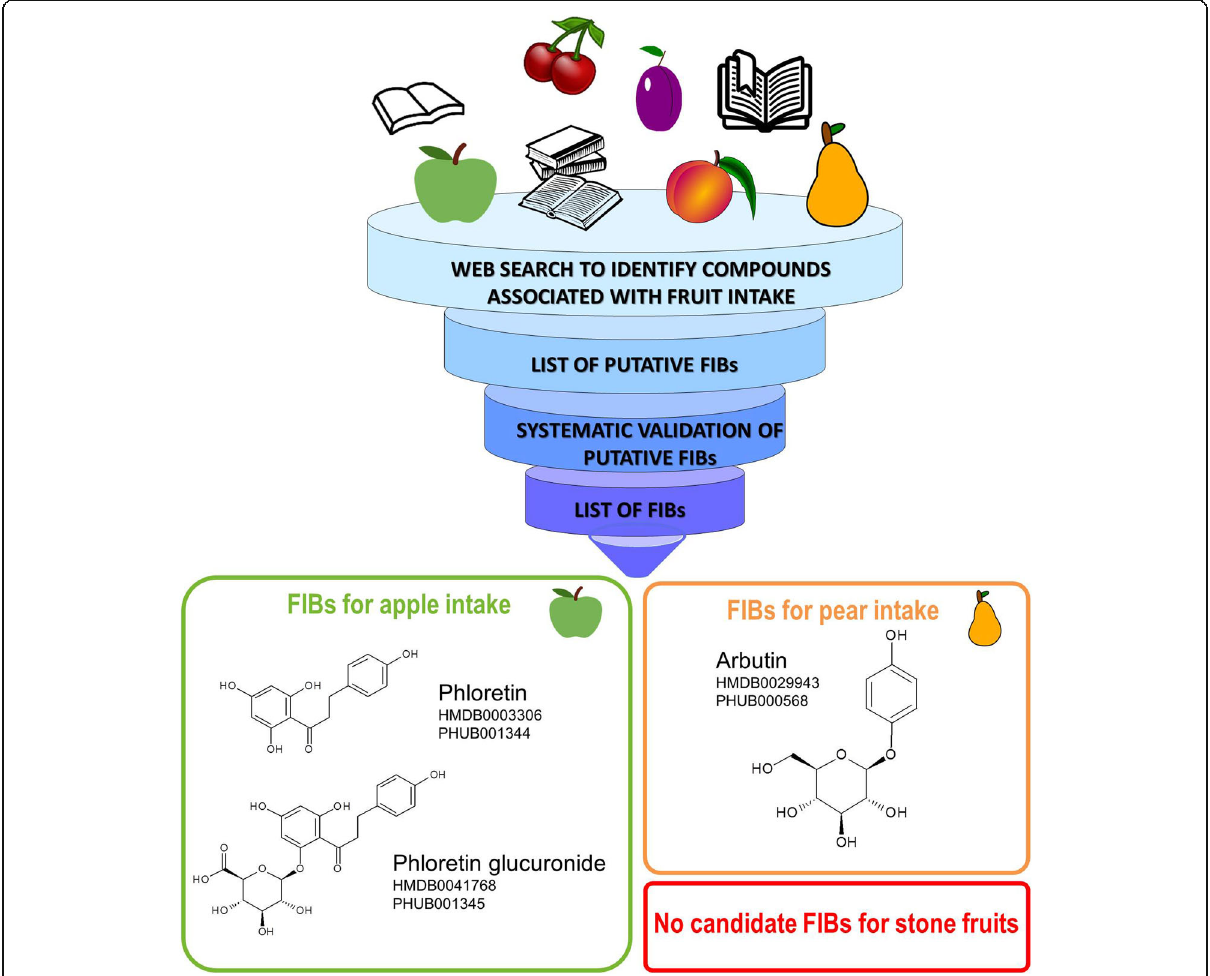
Fig. 2 Scheme of literature evaluation process for pome fruits with BFIs: phloretin, phloretin glucuronide, and